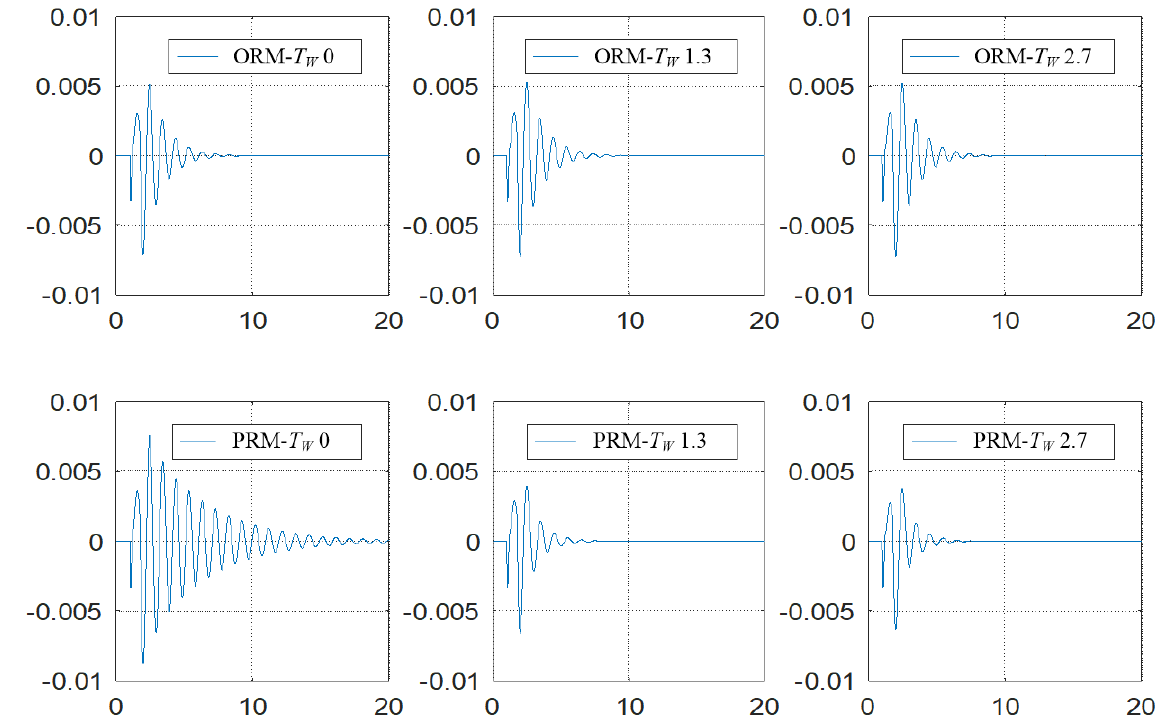
Figure 9. Response of power angle δ under three-phase short circuit.